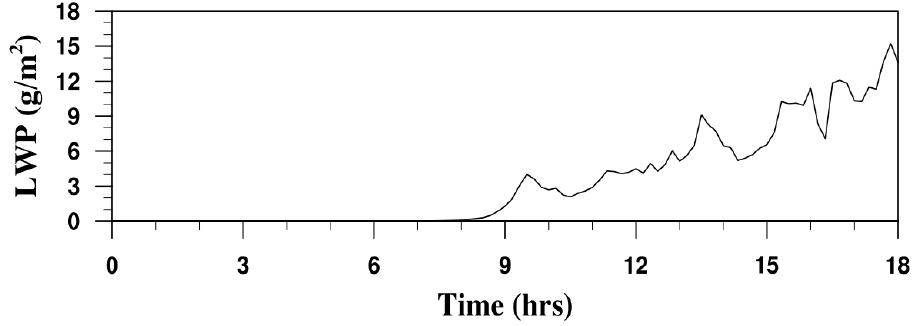
Figure 2. Time evolution of liquid water path.